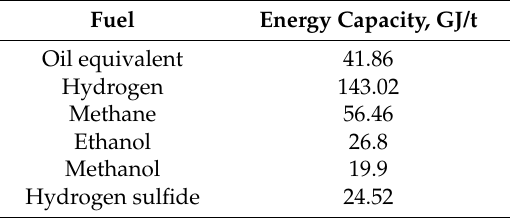
Table 1. Comparison of the energy capacity of some known energy sources to that of hydrogen sulfide.